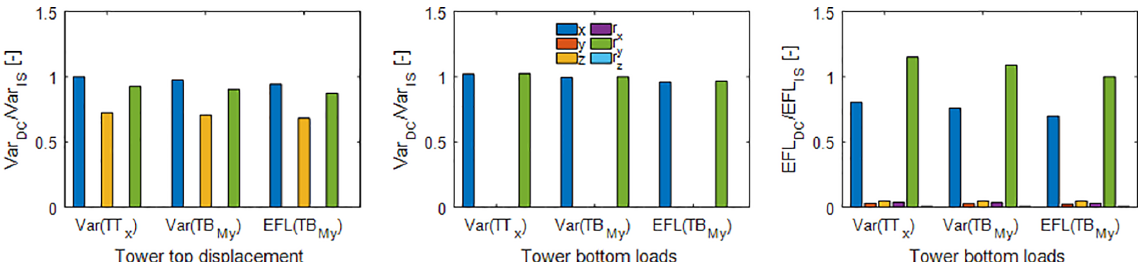
Figure 3. Response for tower top displacements and tower bottom loads for DC I and a wind speed of 8ms − 1 . Damping coefficients matching the variance of the tower top displacement in x direction (Var(TT x )), the variance of the tower bottom bending moment around the y axis (Var(TB My )), and the EFL of the tower bottom bending moment around the y axis (EFL(TB My )) are chosen for the decoupled analysis. Each bar stands for a displacement or force/moment in 1 out of the 6 degrees of freedom.